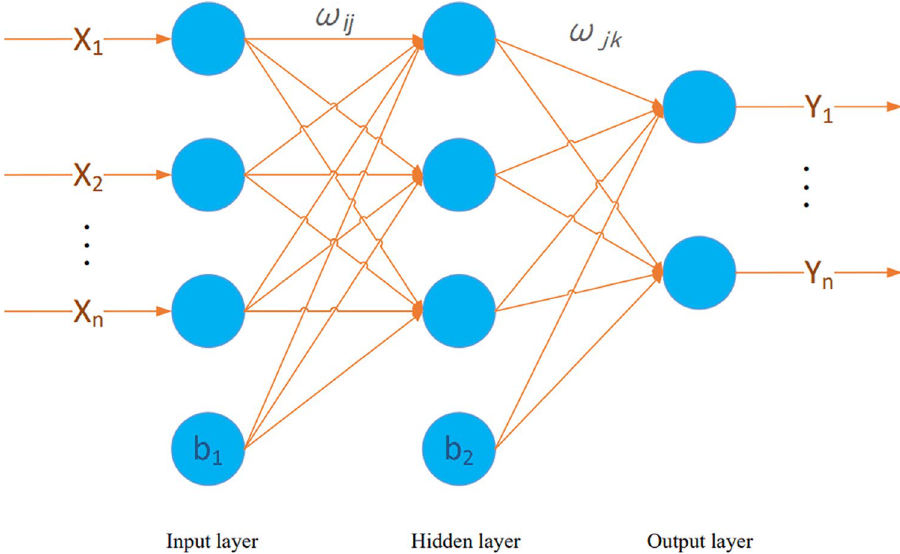
Figure 1. Neural network topology